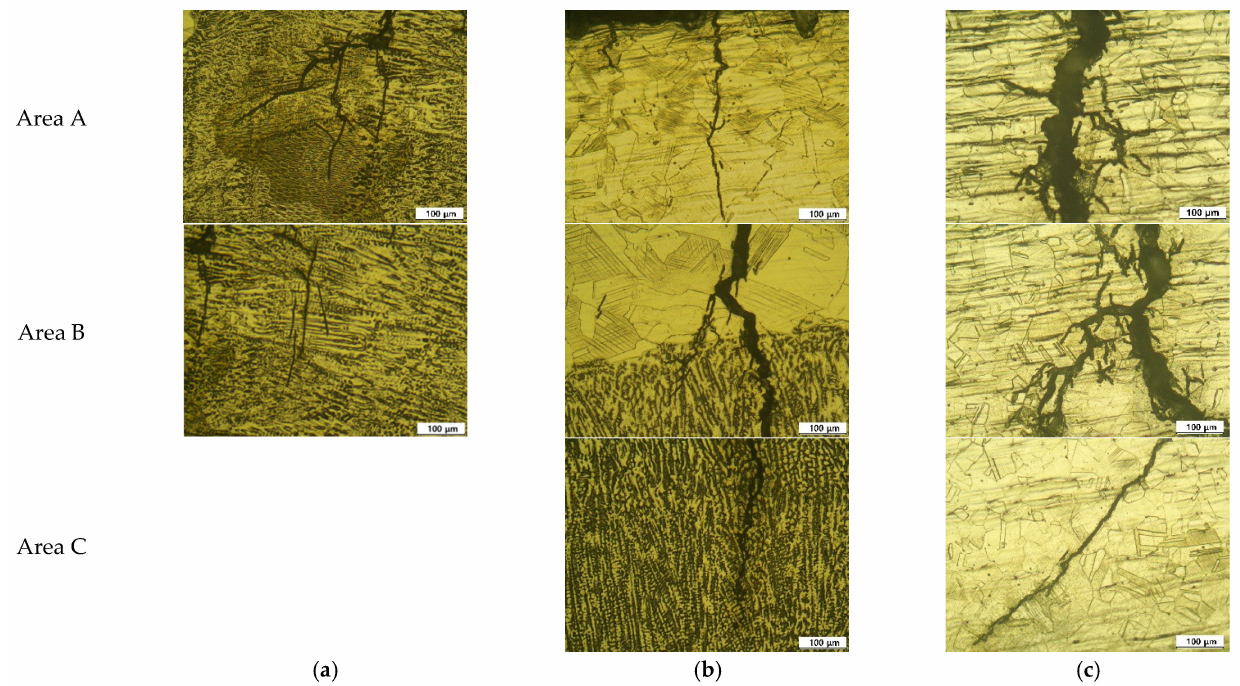
Figure 10. Crack morphologies of 304LW after U-bend SCC test (OM, × 200, 155 ◦ C, 42% MgCl 2 , Areas A, B, and C in Figure 10): ( a ) 304LW; ( b ) 304LW − L − NC; ( c ) 304LW − L − WC.